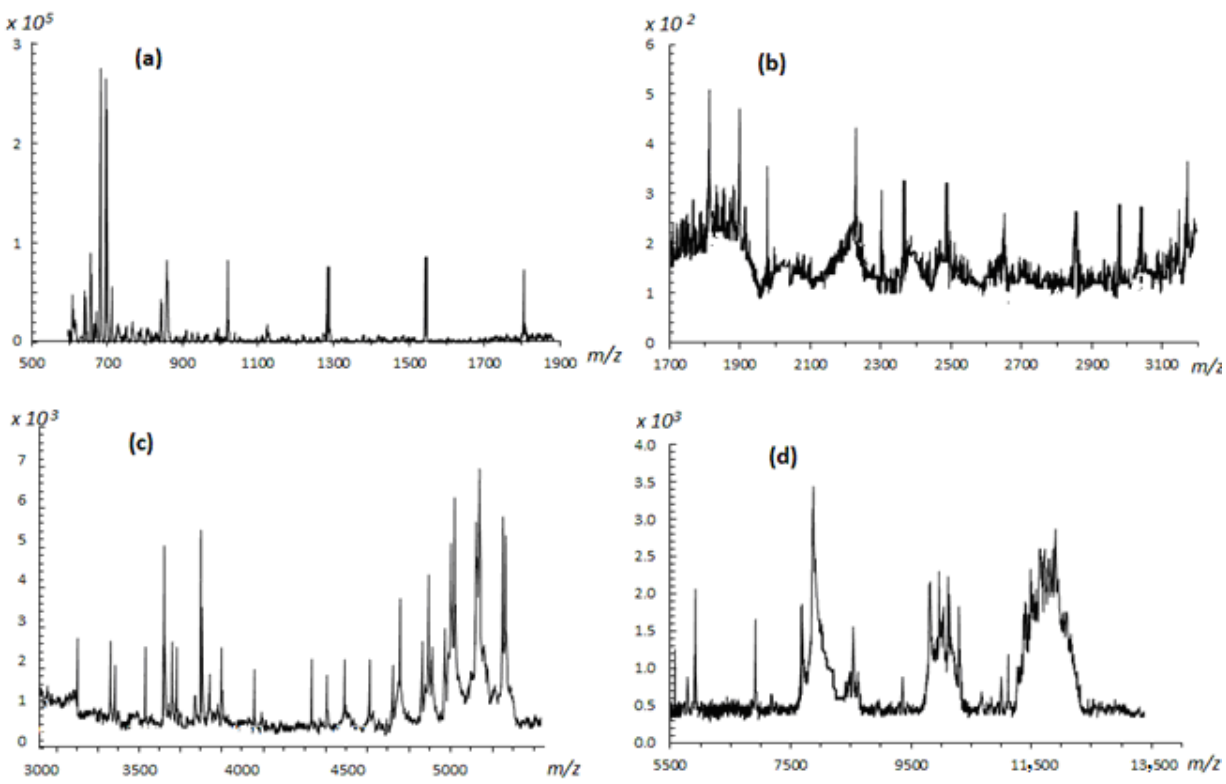
Figure 2. MALDI-TOF mass spectra of rhamnoxylan in ( a ) 500–1900, ( b ) 1700–3100, ( c ) 3000–6000 and ( d ) 5500–14,000 m/z ranges.